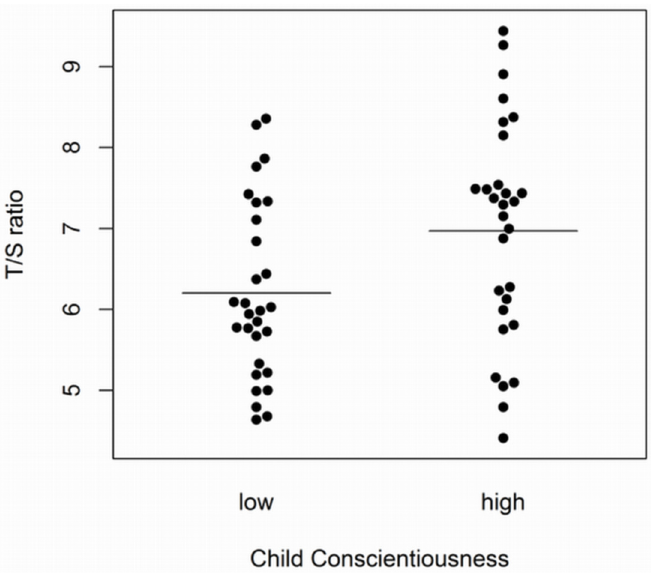
childhood conscientiousness. Group means are displayed as horizontal line.